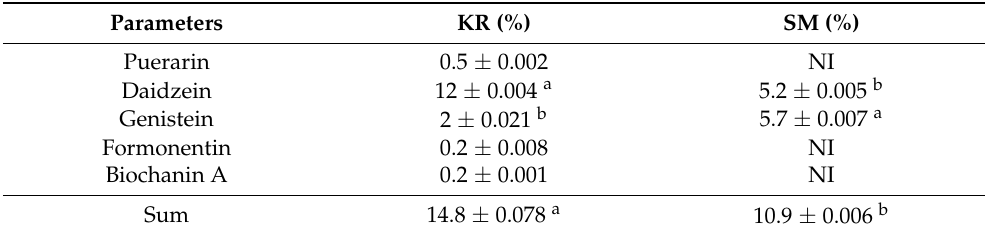
Biochanin A 0.2 ± 0.001 NI Sum 14.8 ± 0.078 a 10.9 ± 0.006 b